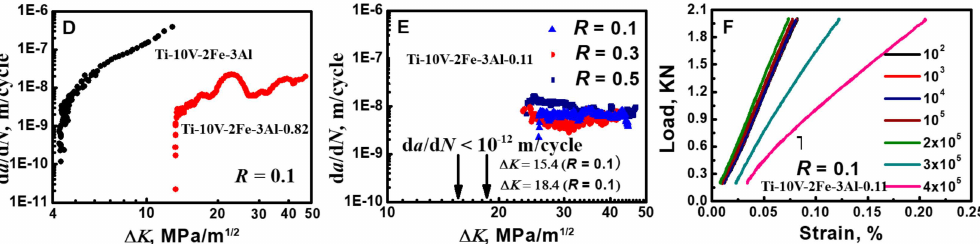
Figure 5. ( A – C ) Ti-10V-2Fe-3Al, Ti-10V-2Fe-3Al-0.82, and Ti-10V-2Fe-3Al-0.11 specimens after tests, in which ( C1 – 3 ) show the deflected and branched cracks in higher magnifications of ( C ) in turn. ( D , E ) Fatigue crack growth rate vs. stress intensity factor range, in which the arrows denote the specimens having d a / d N less than 10 − 12 m / cycle. ( F ) Loading and unloading–strain curves measured by a strain gauge adhered to the crack front and their variations with cycle numbers. ( G ) Electron backscattering di ff raction (EBSD) image of a fatigue crack. ( H , I ) TEM images of crack tip in low and high magnifications. ( J ) Variations of selected area di ff raction (SAD) patterns away from the crack